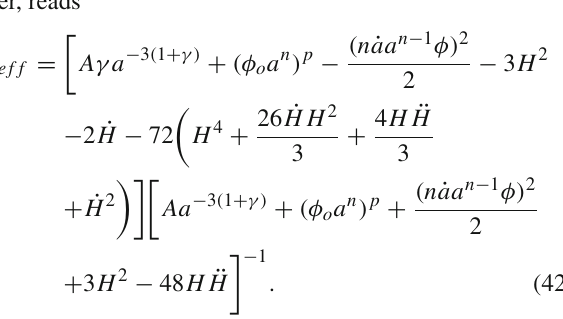
Fig. 1 Plotof w ef f versus z